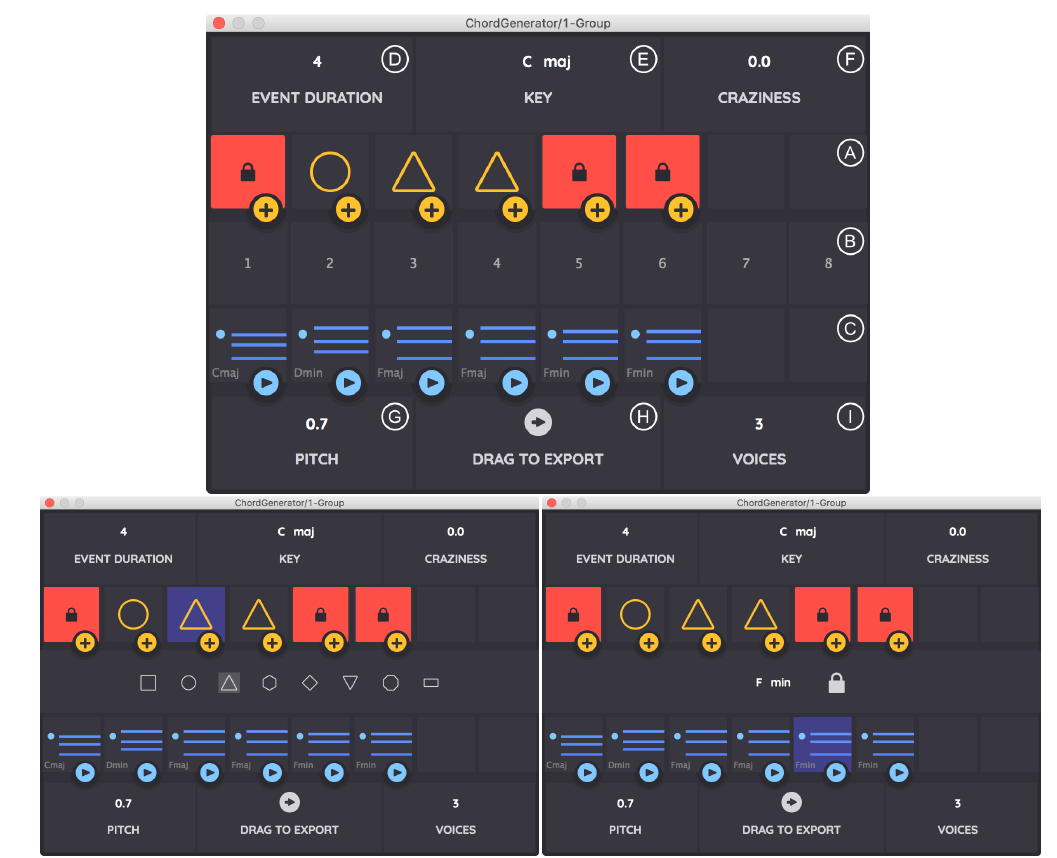
Figure 4. The chord generation plug-in, showing three different states for the construction zone B : variant selection (top), pattern definition (bottom left), and chord locking (bottom